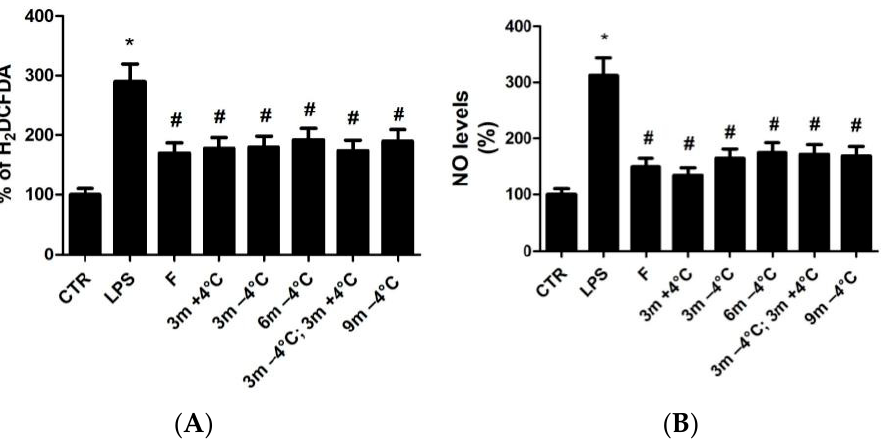
Figure 5. The effect of D ‐ VGEs at different storage conditions on the modulation of LPS ‐ stimulated oxygen radical release (DCFDA) ( A ) and NO ( B ) in macrophage RAW 264.7 cells. * p < 0.01 versus control (CTR). # p < 0.01 toward LPS. Analysis by ANOVA followed by Dunnett’s test, N = 3.